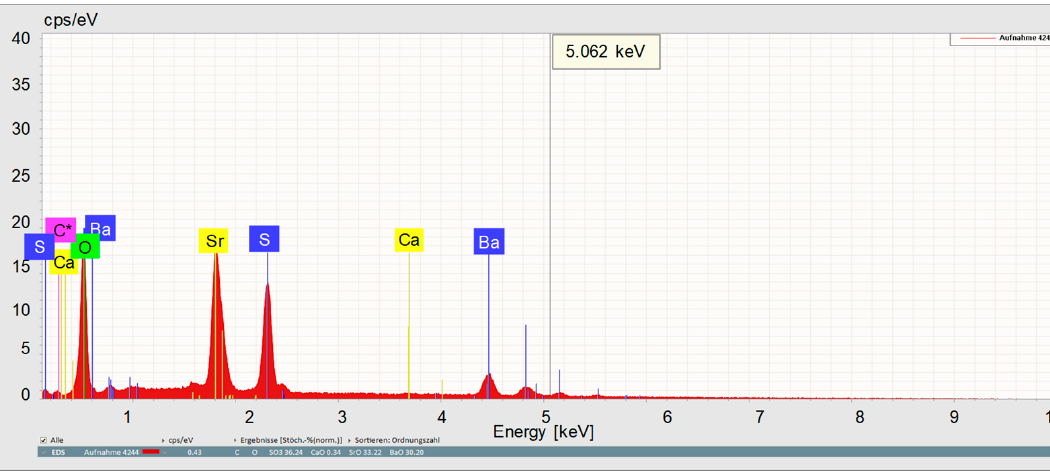
Figure 20. Spectrum of the flake shown in Figure 19, showing phosphorus and sulfur peaks. 4.3. Purification of the Leach Solution After digestion and leaching of the monazite, the sulfate solution needs to be purified before the REE carbonate precipitation. This can be accomplished by adjusting the pH of the solution to a desired value that is suitable for impurity precipitation with minimum co-precipitation of REEs. After removing the impurities as metal hydroxide precipitates, the REE carbonate precipitation can be realized. Typically, ammonium solution or magnesium oxide is used to increase the pH. The use of sodium hydroxide is not possible due to the formation of insoluble sodium REE double sulfates. To define the precipitation conditions, different experiments were carried out, as described below. The main impurities in the leachate of a single-stage digestion (see Experiment A in Figure 16) are aluminum, calcium, iron, phosphorus, and thorium. The ion concentration of a typical leach solution is shown in Table 6. Table 6. Metal ion concentration of a typical leach solution with high impurity content. Element